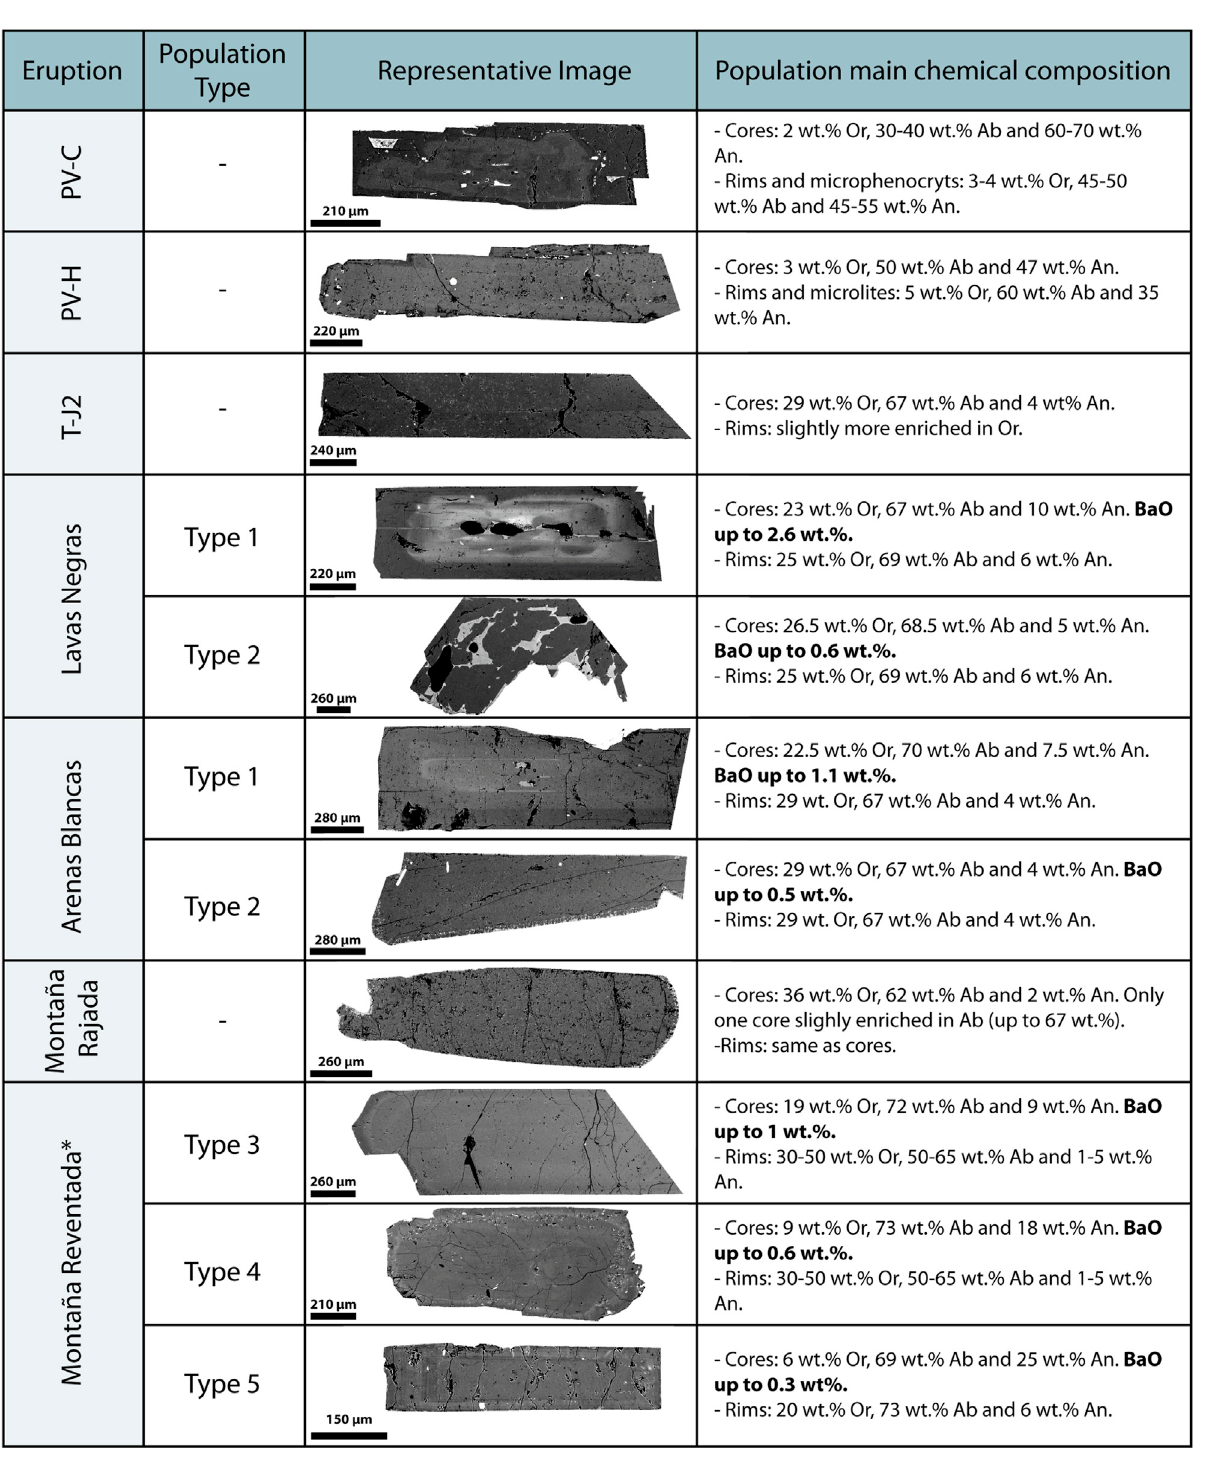
Frontiers in Earth